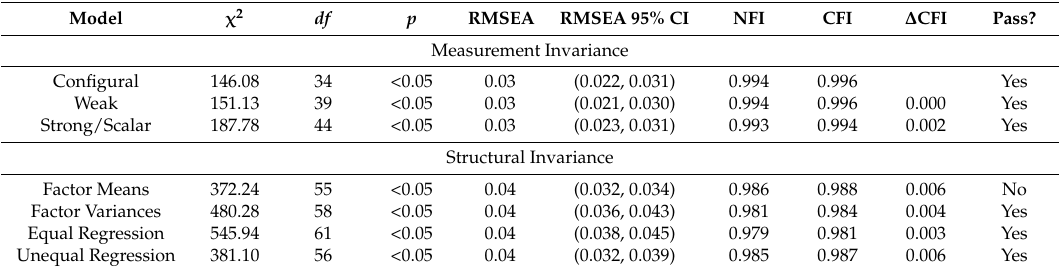
Table 2. Fit Indices for Multigroup Invariance Comparisons Based on SES—Measurement model 3 and SEM model 4.